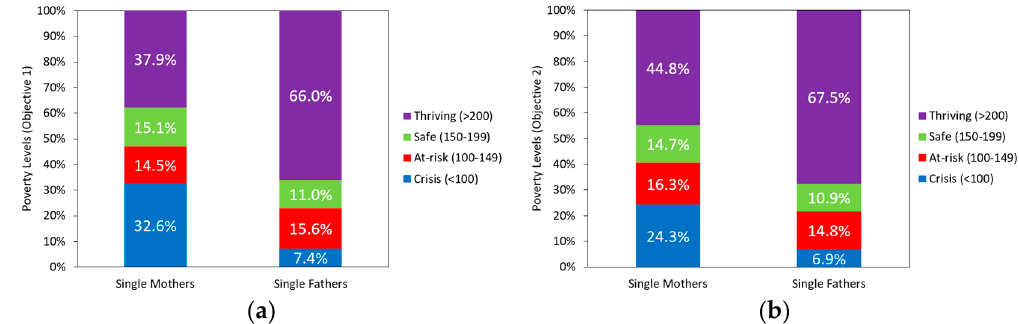
Figure 1. Poverty levels of single mothers and single fathers: ( a ) poverty status is taxable income divided by poverty threshold for Objective 1; and ( b ) poverty status is total income divided by poverty threshold for Objective 2.